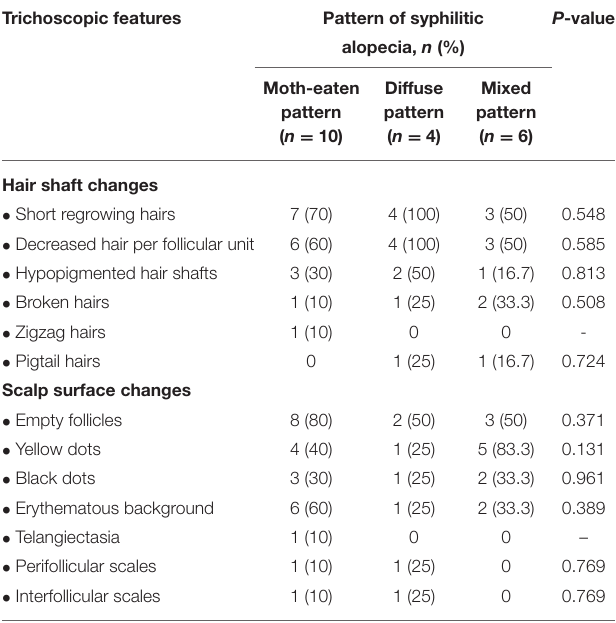
Hair shaft changes